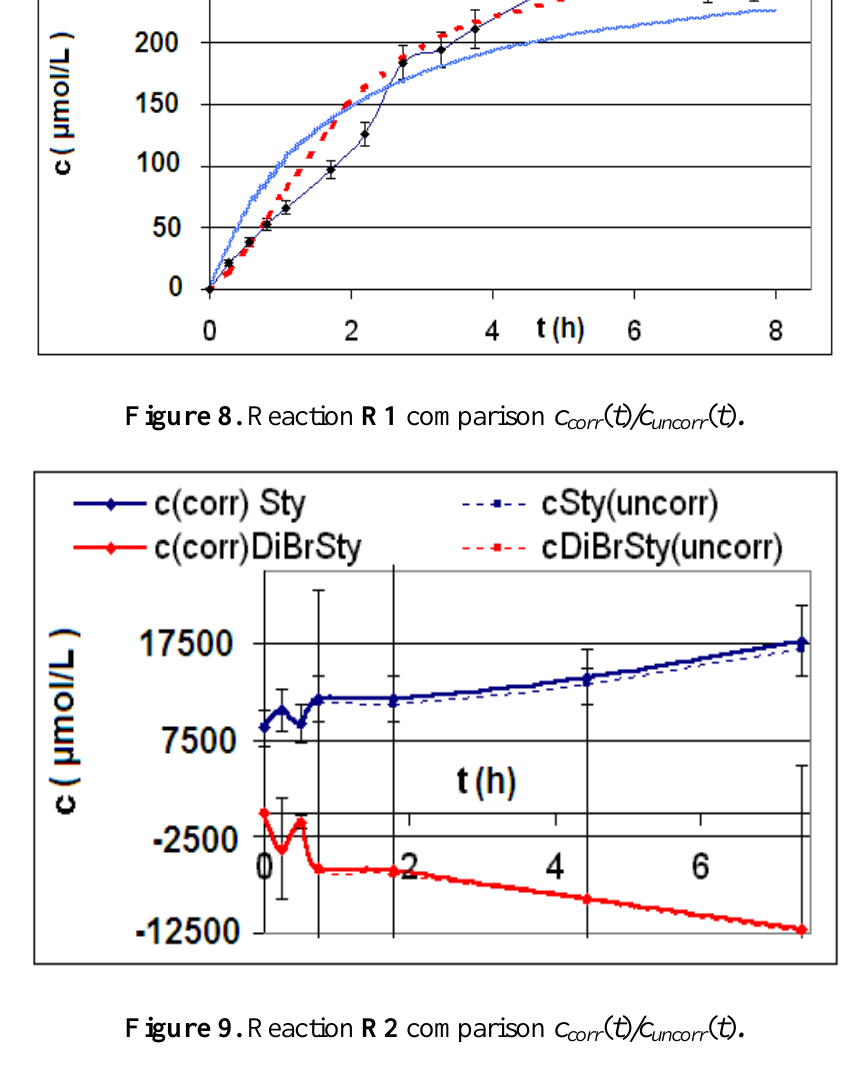
Figure 9. Reaction R2 comparison c